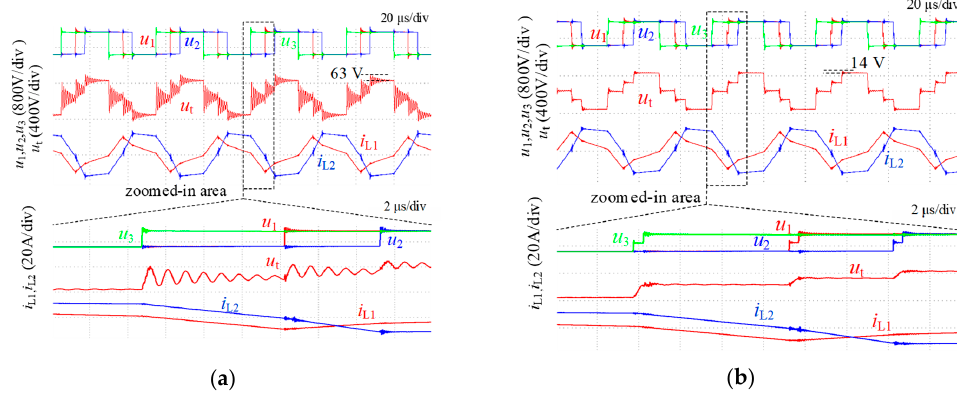
Figure 16. Waveforms of the TAB converter with reverse power flow ( D 1 = 0, D 2 = 0.2, D 3 = − 0.3): ( a ) no suppression; ( b ) with the SHE PS method.